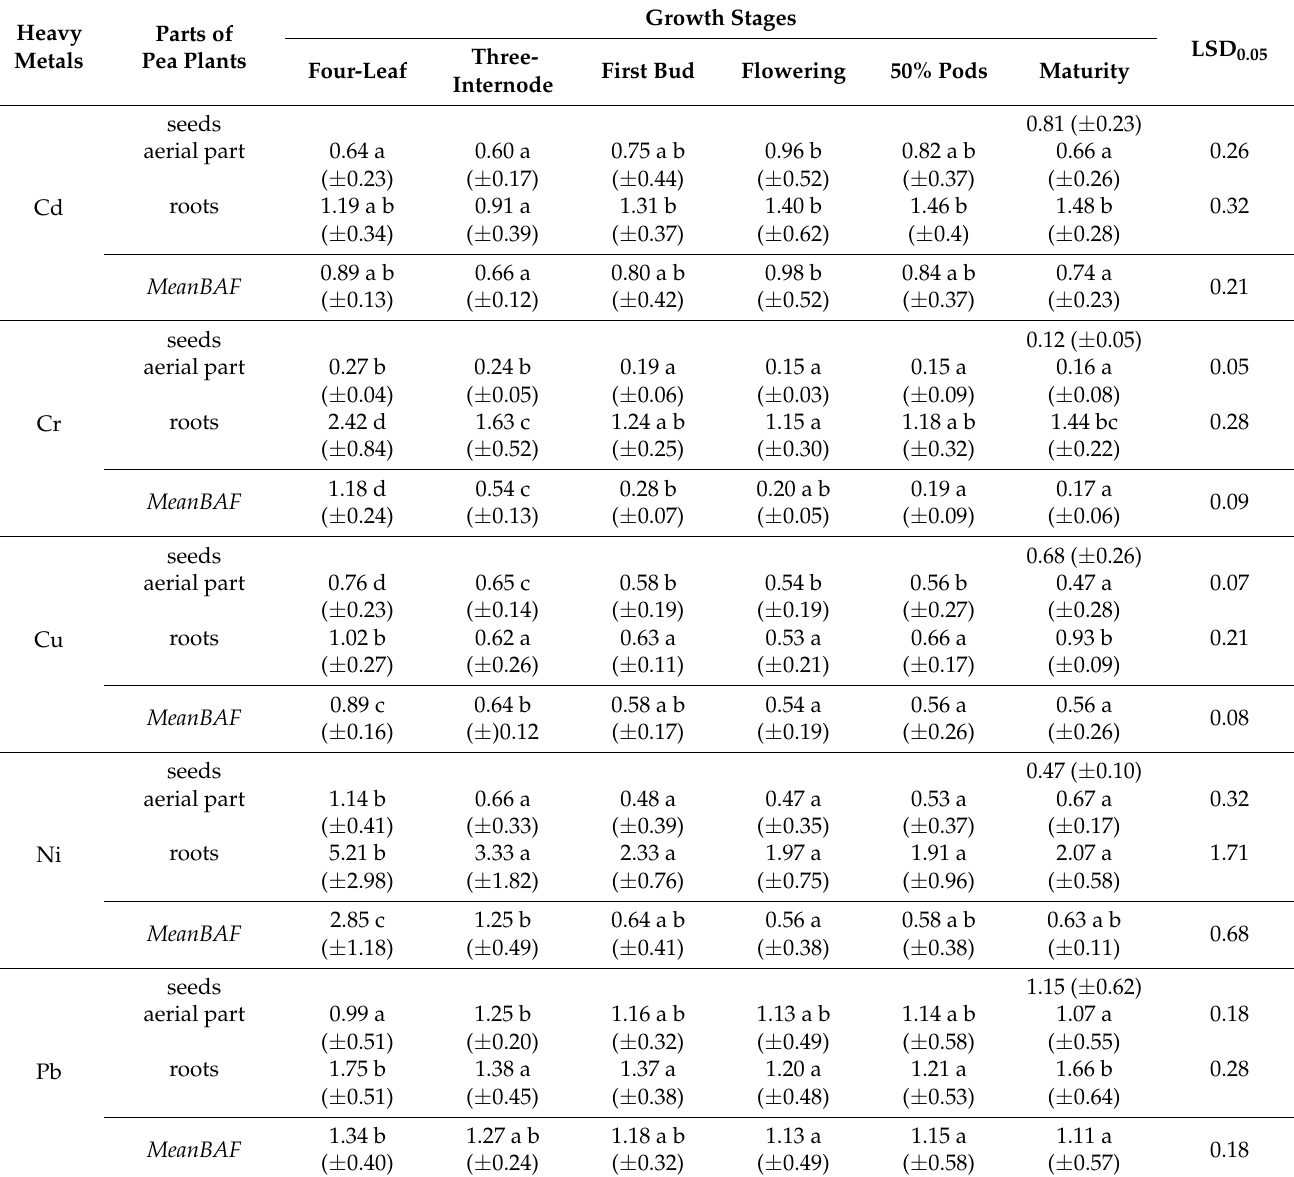
Table 9. BAF of heavy metals in pea plants’ successive growth stages (mean values ± SD of two cultivars and two successive years with three repetitions